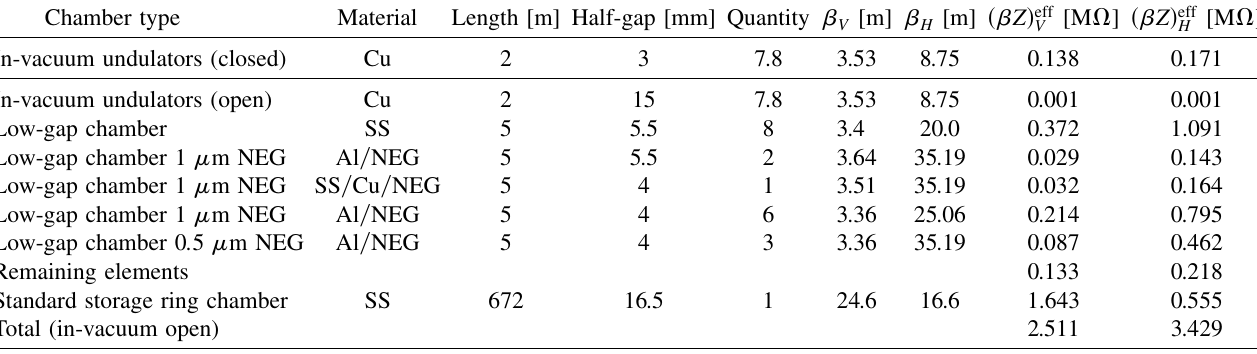
TABLE II. Resistive wall budget vertical and horizontal plane. SS stands for stainless steel, NEG is explained in the text. All in- vacuum undulators are 2 m long except the prototype of 1.6 m length (therefore a fractional quantity is written). The first line is only given for information and not taken into account in the budget.